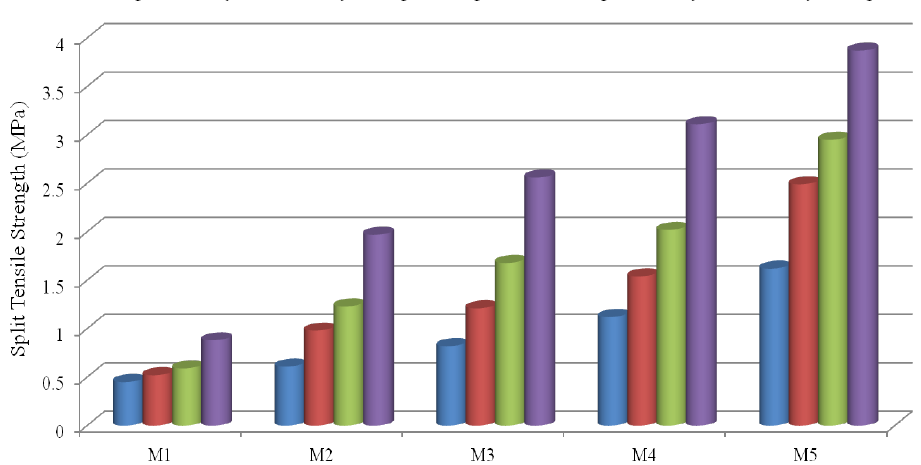
Figure 6. Split tensile strength of geopolymer concrete at different mix proportions.